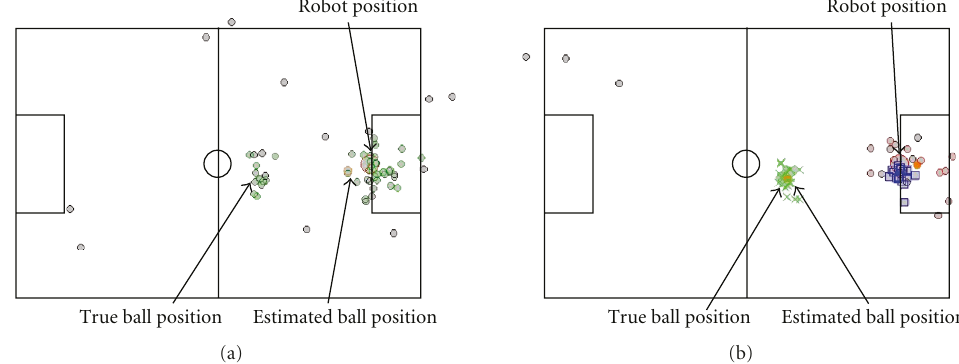
Figure 6: Example illustration of the simulated world where the robot has just kicked the ball. The vanilla RBPF estimator tracking the ball (a). The hybrid bank of RBPF estimators tracking the ball in (b). In (b), the three di ff erent hypotheses are represented as di ff erent shaped particles (vision: circle, kicksuccess: cross, kickfailure: square).